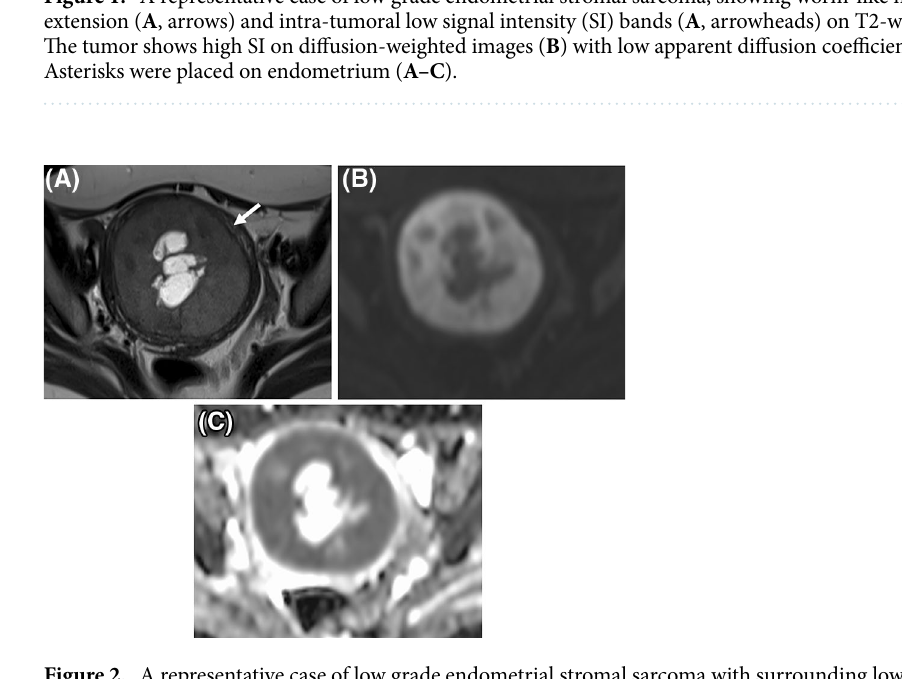
Figure 2. A representative case of low grade endometrial stromal sarcoma with surrounding low signal intensity (SI) rim on T2-weighted images ( A , arrow). Cystic/necrotic change is also observed. Solid parts of tumor shows high SI on diffusion-weighted images ( B ) with low apparent diffusion coefficient values ( C